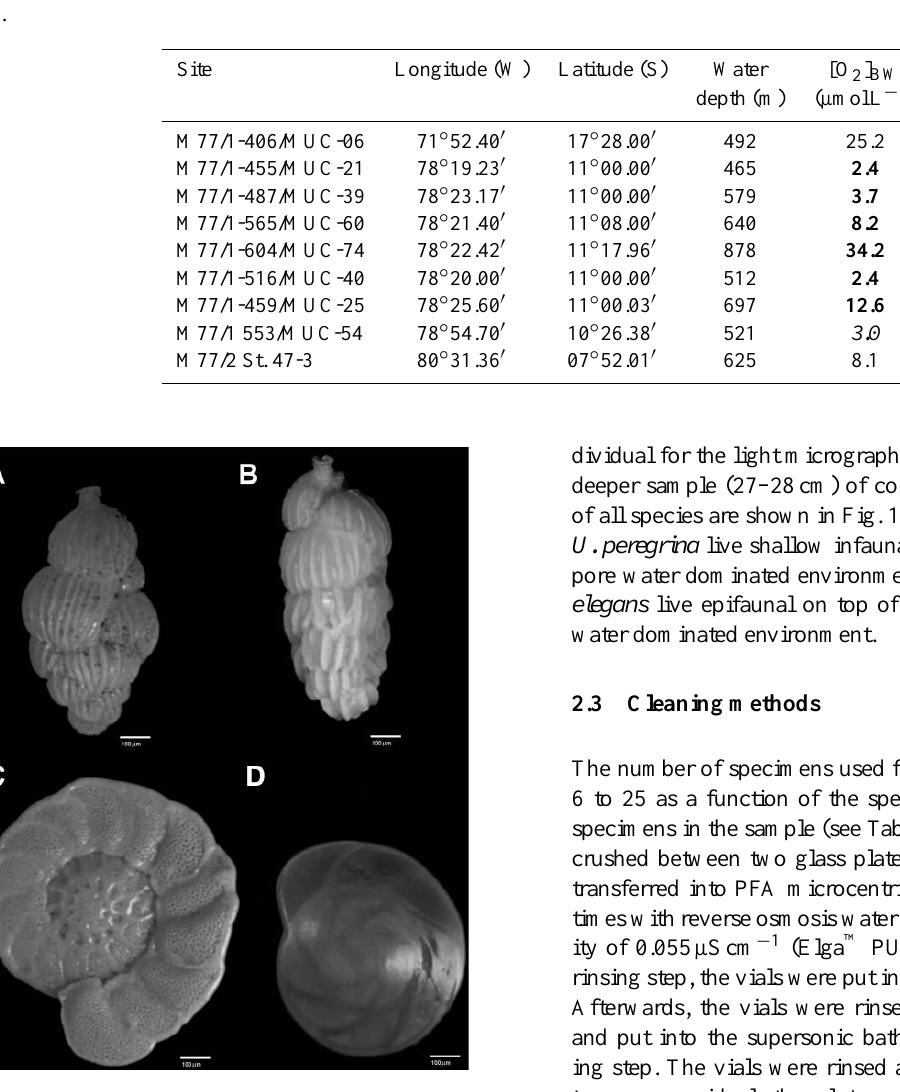
Figure 1. Photographs of the foraminiferal species used in this study. (a) Uvigerina striata , (b) Uvigerina peregrina , (c) Planulina limbata , (d) Hoeglundina elegans